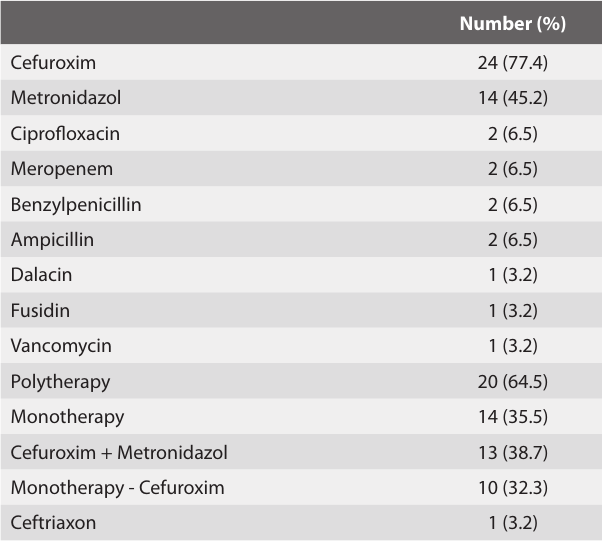
Table 4. Overview of the initial antibiotic treatment of the 31